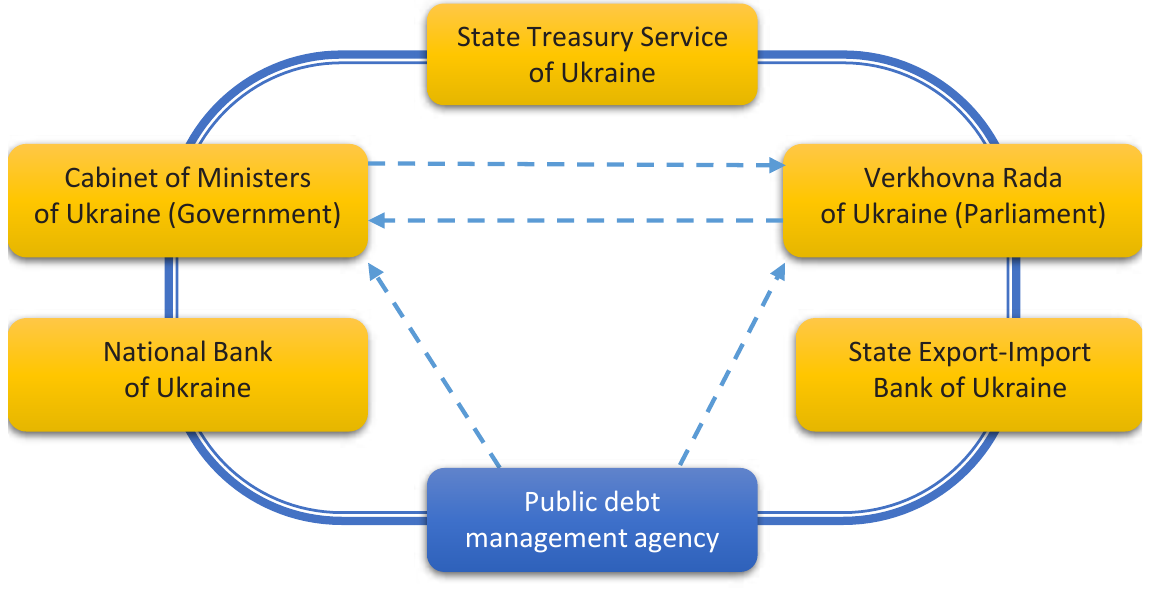
Figure 5. Institutional model of the public external debt